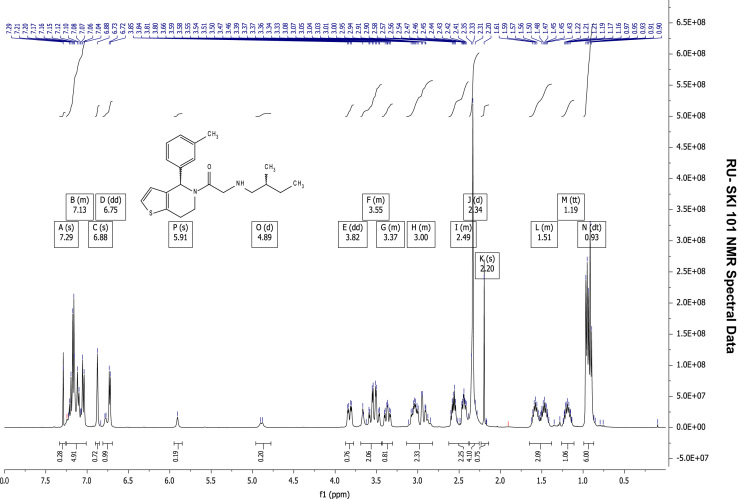
1H NMR (400 MHz, CDCl3) of RU-SKI 101
(9c).